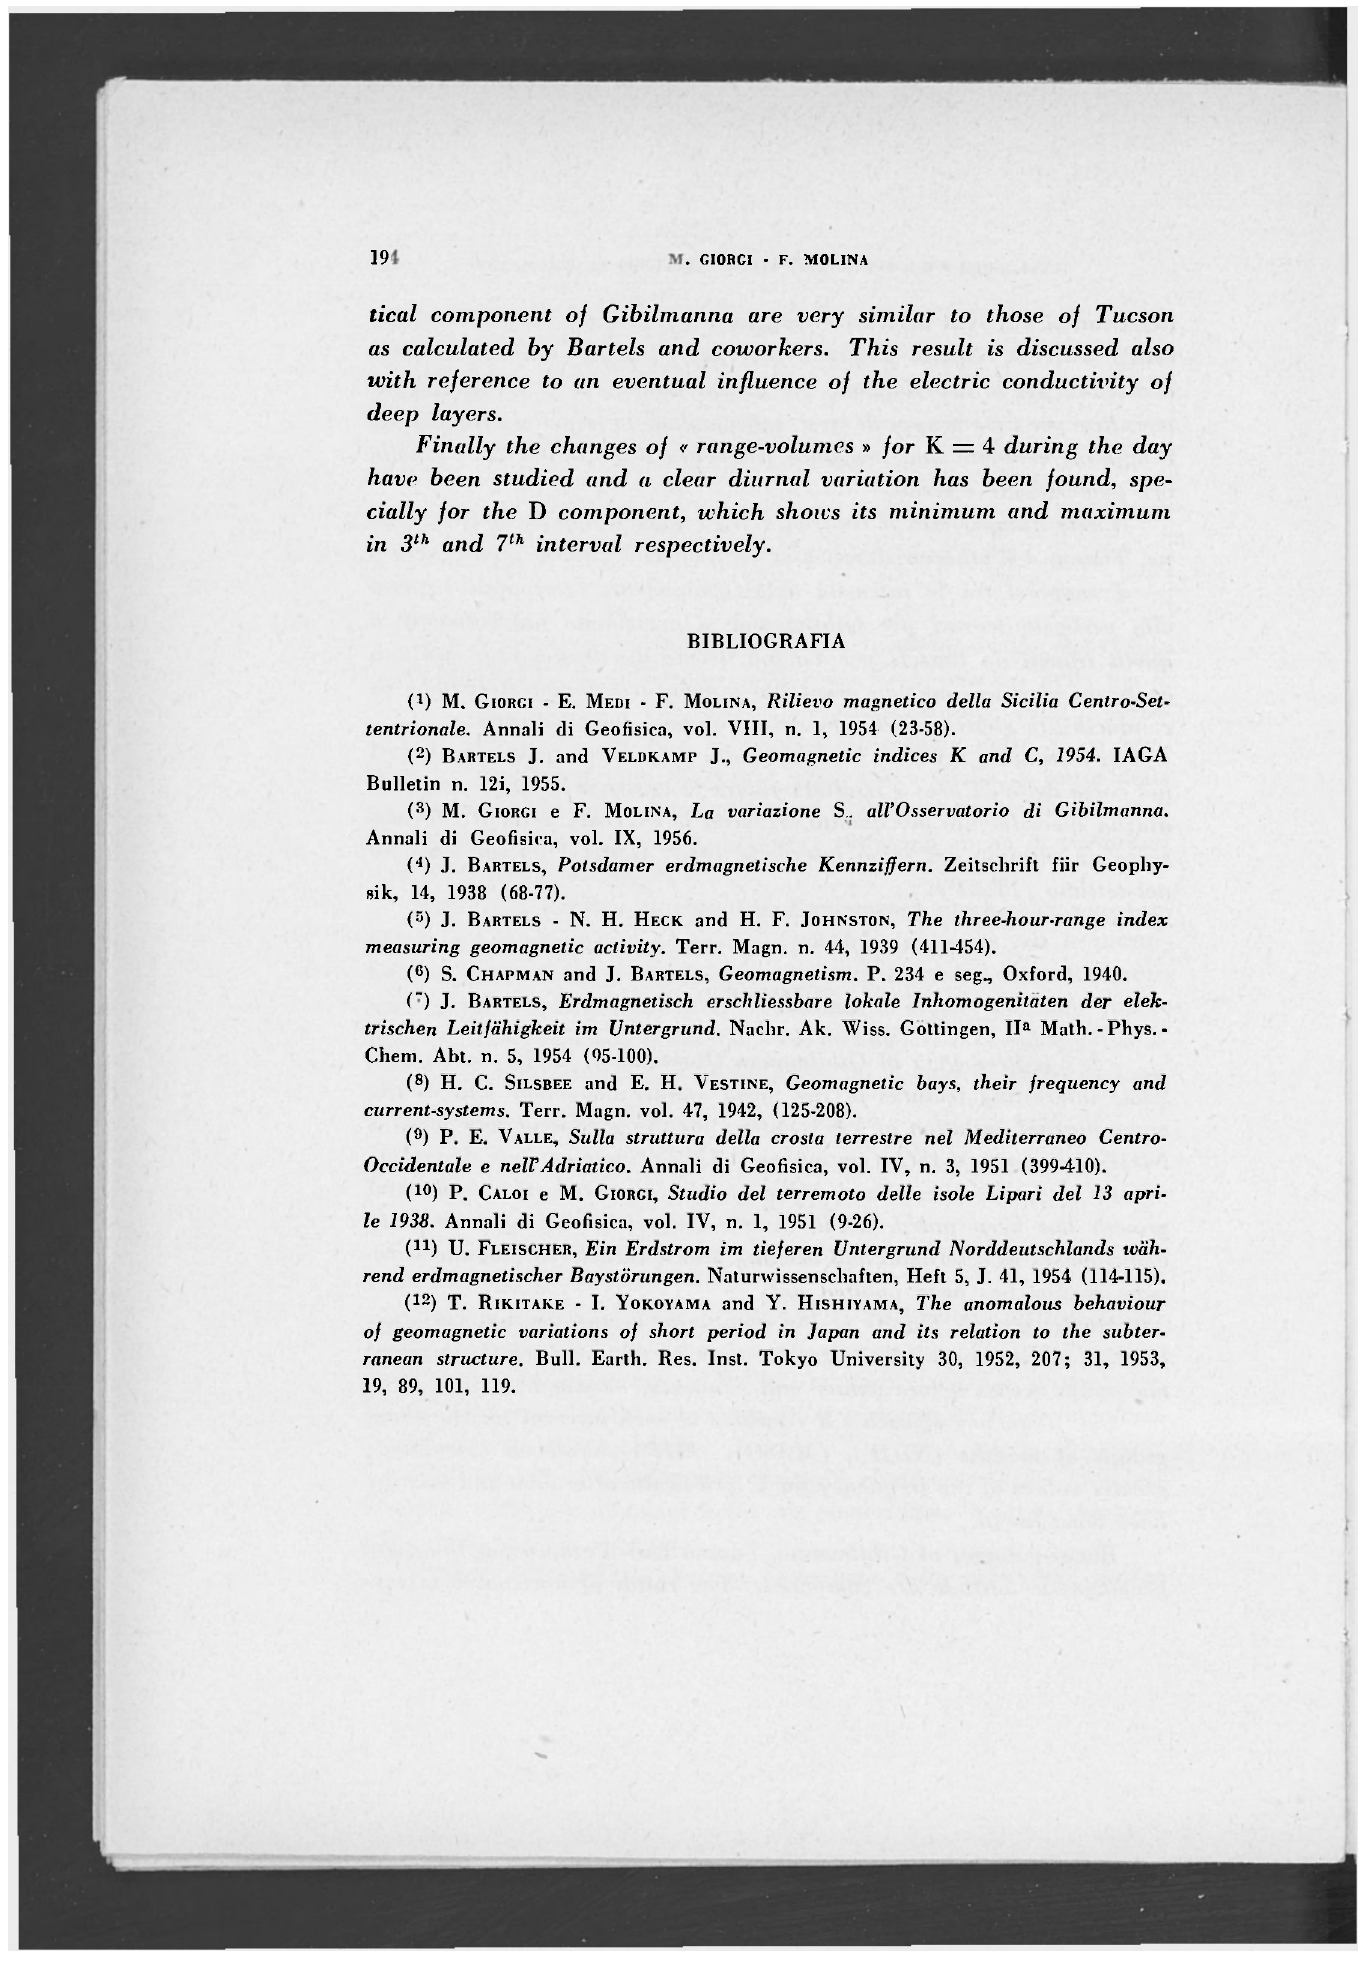
tical component of Gibilmanna are very similar to those of Tucson as calculated by Bartels and coworkers. This result is discussed also with reference to an eventual influence of the electric of deep layers. Finally the changes of « range-volumes » for K = 4 during the day have been studied and a clear diurnal variation has been found, spe- cially for the D component, which shoivs its minimum and maximum in 3 th and 7 ,h